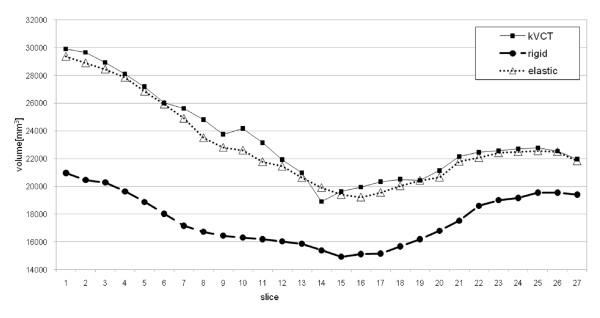
Slice-by-slice volume comparison in left lung (patient 1). kVCT lung volume (full square), rigidly realigned MVCT lung volume (full circle) and elastically registered MVCT lung volume(triangle). The rigid volume trend demonstrated volume reduction in MVCT due to large left lung atlectasis increase and mediastinum shift in the direction of left lung. Elastic volume trend well fitted the kVCT trend demonstrating good recovering of deformation.